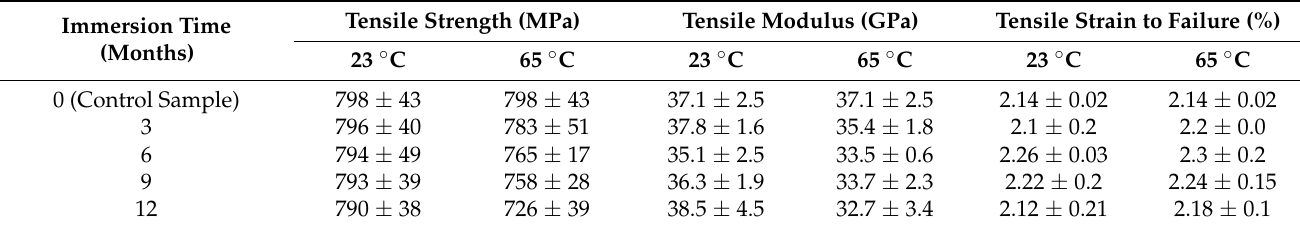
Table 3. Tensile properties of E-glass/epoxy composite immersed in seawater at 23 °C and 65 °C. Immersion Time